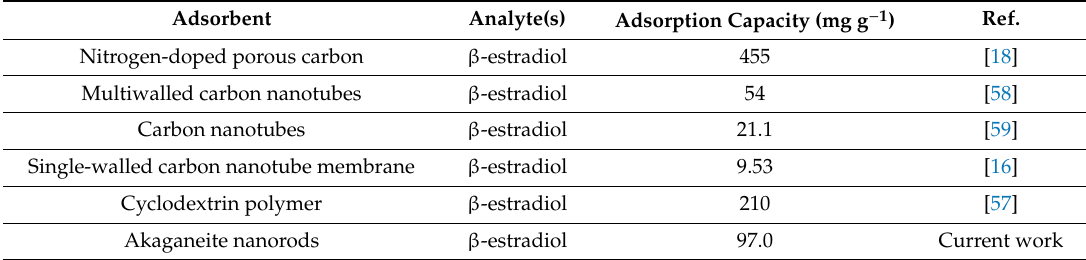
Table 5. Comparison of materials used in previous reports for the removal of β -estradiol from water samples.